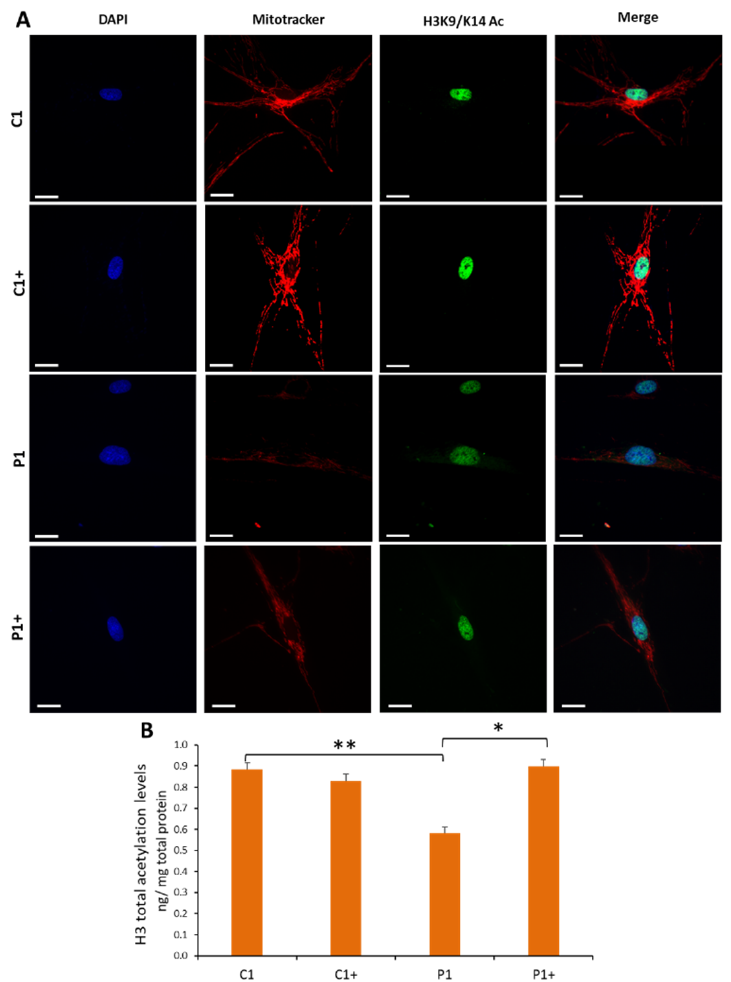
Figure 4. Pantothenate and L-carnitine treatment increases histone acetylation levels in KAT6A fibroblasts (P1). Control (C) and mutant P1 fibroblasts (P1) were treated with 0.7 µ M pantothenate and 0.7 µ M L-carnitine for 15 days (C+ and P1+). ( A ) Control and KAT6A fibroblasts were